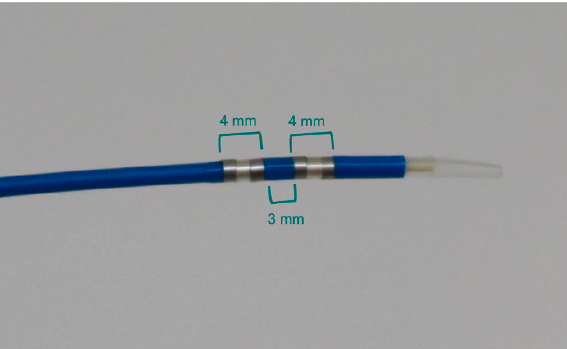
Figure 1. Electrode catheter for endoluminal radiofrequency ablation (RFA). The distal end of the catheter has two circumferential 4-mm-wide RFA electrodes, separated by a distance of 3 mm, providing cylindrical ablation over an 11-mm length.